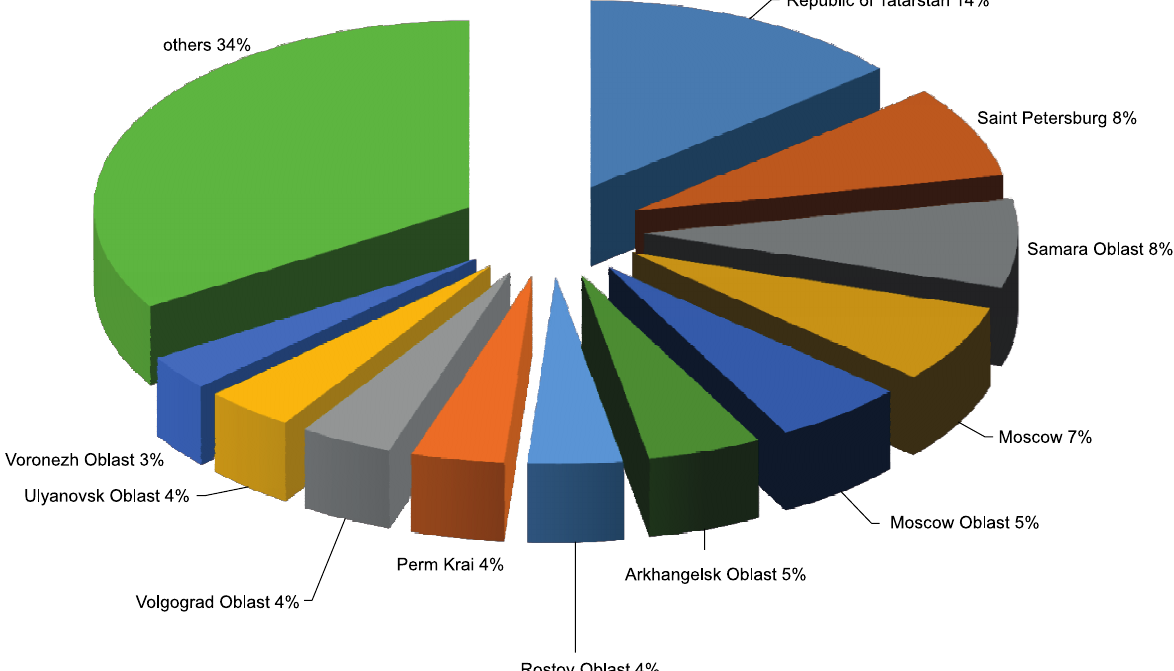
Fig. 3. Employment in clusters in Russia by regions in 2017 (in %). The total number of employees: 1,452,870